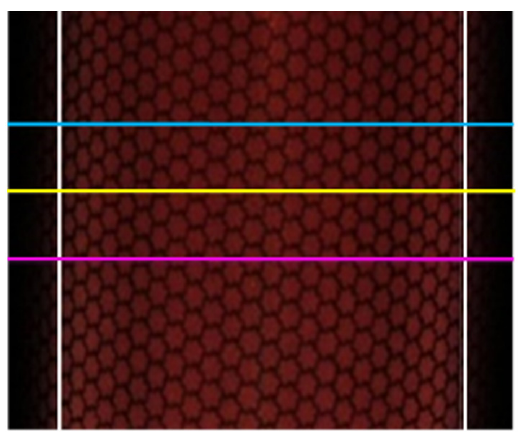
Figure 6. Example of captured image and verification position (horizontal lines between white vertical lines).